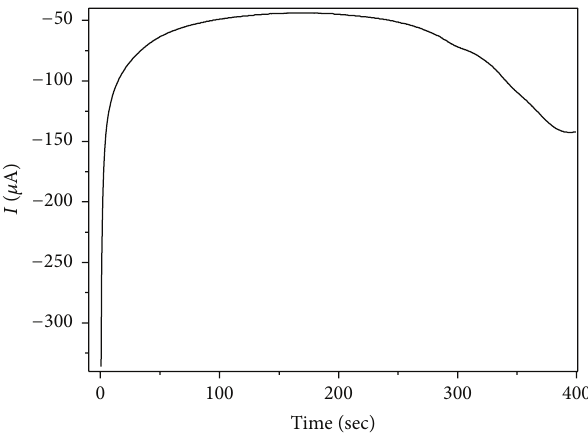
Figure 2: Current time curve for polypyrrole overoxidation (OvOxPpy || GCE).